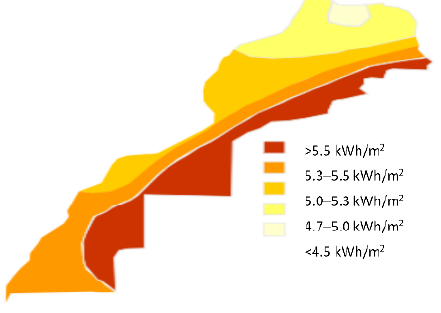
Fig. 1. Solar irradiation map of Morocco (MASEN)